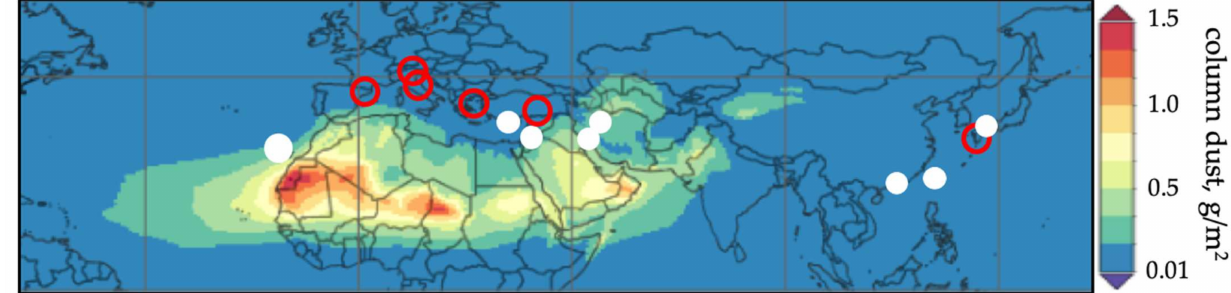
Figure 6. Distribution of the regions in which the studies on dust and cardiovascular disorders have been carried out based on the systematic review. Note the regions (white dot) in which the PM 10 levels during the dust episodes are high, i.e., two or more times higher than those recorded in the absence of desert dust (from west to east): Tenerife—Spain, Nicosia—Cyprus, B é erSheva—Israel, Ahvaz—Iran, Teheran—Iran, Hong Kong—China, Taipei—Taiwan, and Fukuoka— Japan. Note the regions (red circle) in which the PM 10 levels during the dust episodes do not increase significantly, i.e., without reaching two times those recorded in the absence of desert dust (from west to east): Barcelona—Spain, Brescia—Italy, Emilia Romagna—Italy, Athens—Greece, Gaziantep—Turkey, and western Japan. Column dust is shown according to MERRA-2